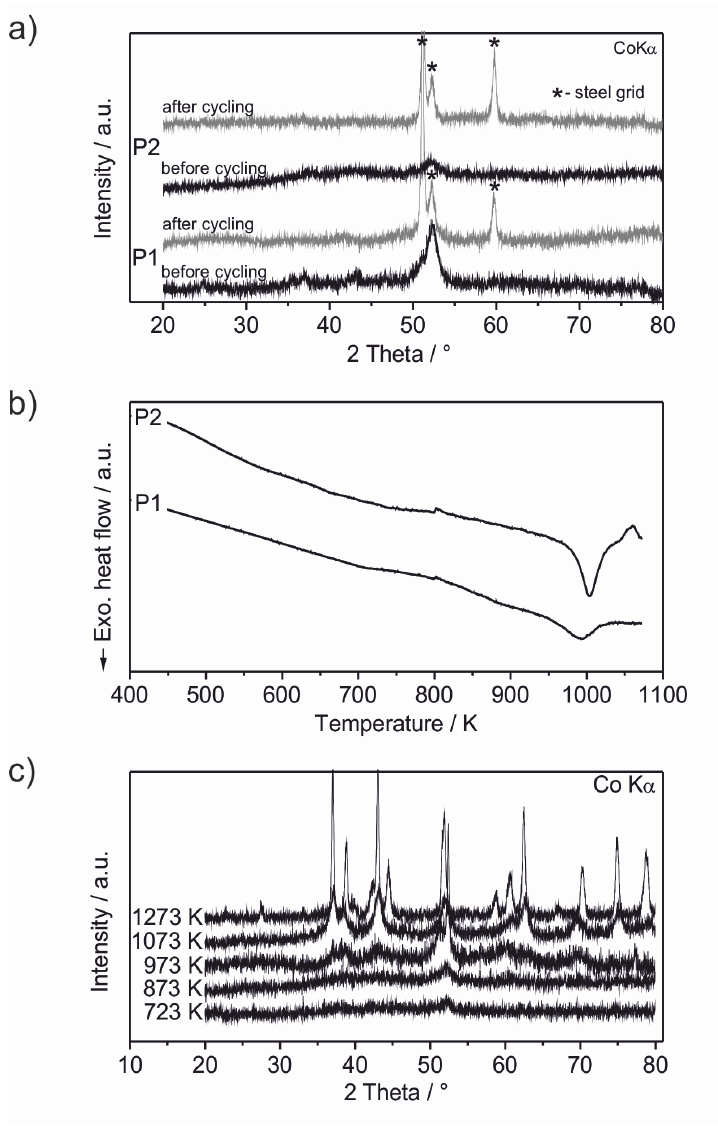
Figure 2. ( a ) XRD patterns of ball milled Al and P2 (silicon nitride milling vial) before and after cycling; ( b ) DSC curves of the powders P1 and P2 (heating rate 20 K/min); ( c ) XRD patterns of powder P2, annealed by DSC. Annealing at 1273 K is carried out within a furnace in a sealed Ta-crucible,